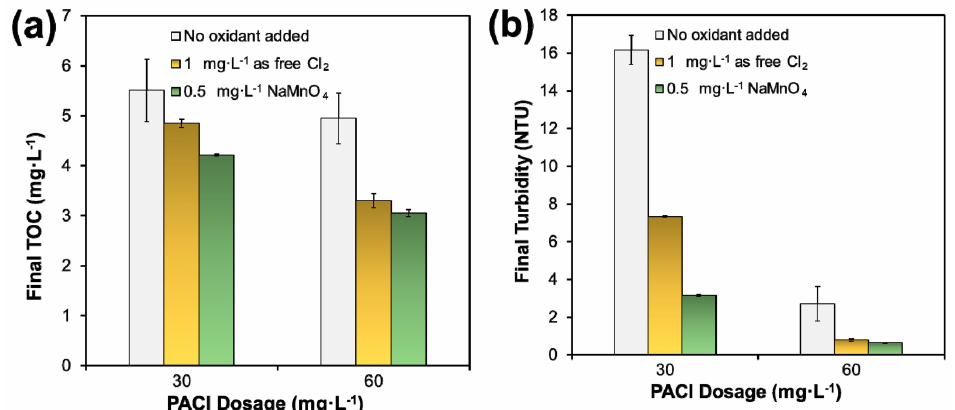
Figure 8. ( a ) TOC removal by NaOCl (1 mg · L − 1 as free Cl 2 ) or NaMnO 4 before coagulation; and ( b ) Turbidity removal with or without pre-coagulation oxidation of NOM using NaOCl or NaMnO 4 . (Temperature = 7 ◦ C, initial turbidity = 70.00 NTU, pH ≈ 7.50, initial TOC = 6.14 mg · L − 1 ; data plotted as mean of duplicates and error bars calculated as standard deviation to indicate data